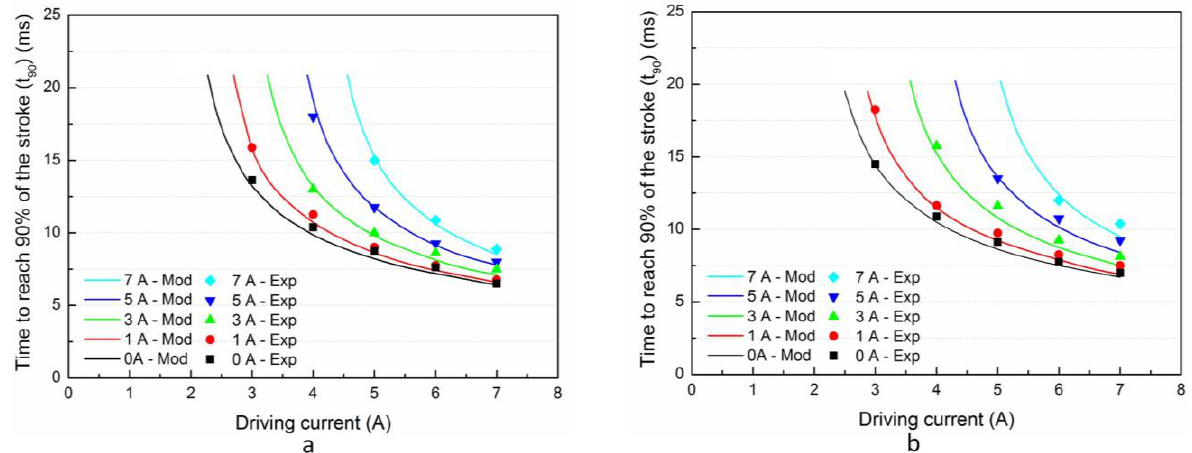
Figure 5. Comparisons between experimental (Exp) and modeled (Mod) MPM displacement: ( a ) influence of driving current without holding current for x -axis switching. ( b ) Influence of holding current with 5 A driving current for x -axis switching. ( c ) Influence of driving current without holding current for the y -axis switching. ( d ) Influence of holding current with 5 A driving current for y -axis switching.